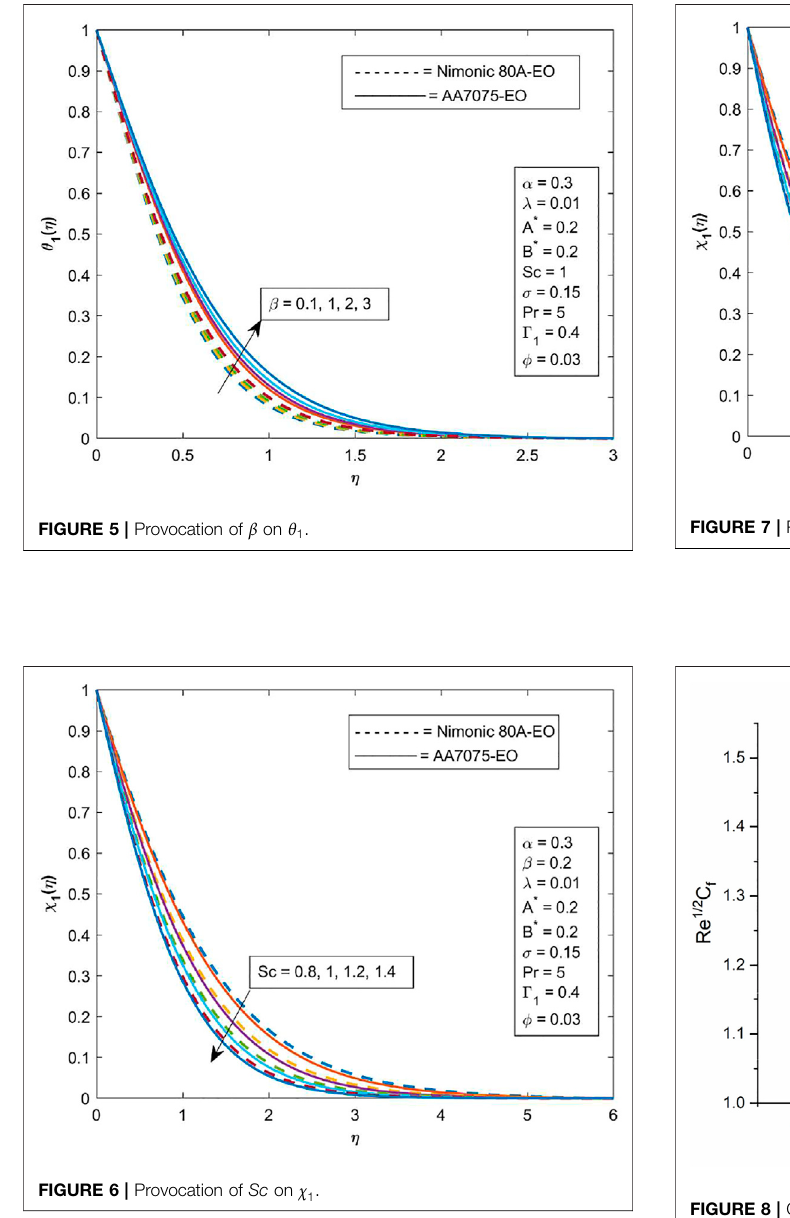
FIGURE 8 | Change in Re − 1/2 C f for β versus Γ 1